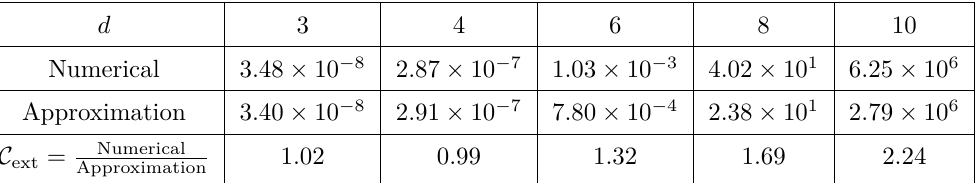
Table 1 . We fix βδr = 100 and r s /L = 100 . For different d we numerically calculate the series r 2 s defined in eq. (2.25) and compare to the approximated evaporation rate we found in eq. (2.30) and eq. (2.33) for d ≥ 4 and d = 3 respectively. We can see that in higher dimensions the approximation is not as good as it is in lower dimension but the results differ by an order one factor given by C ext . Furthermore, if one does similar calculations for larger values of r s /L we will find better agreement between the numerical result and approximated